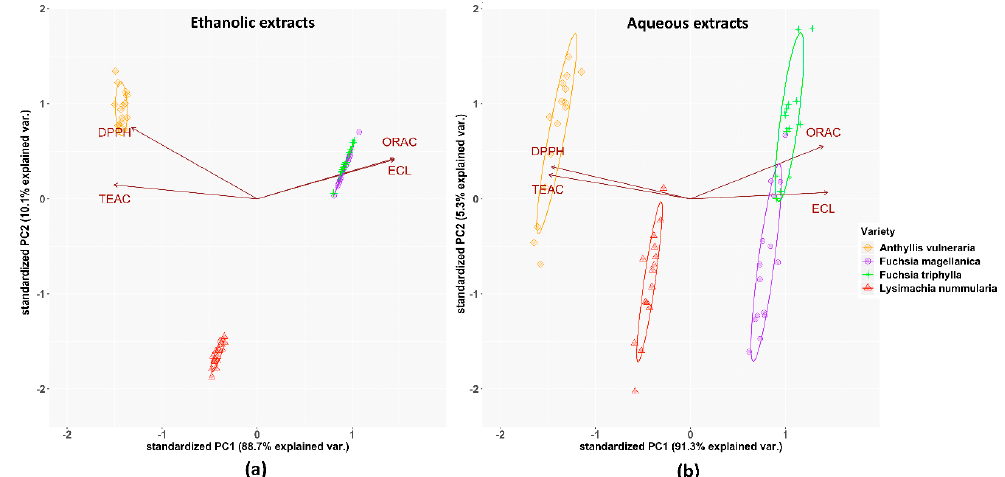
Figure 2. PCA analysis of the investigated plant species’ total antioxidant capacity by four independent methods: ( a ) in the ethanolic extracts, ( b ) in the aqueous solutions, based on the antioxidant activities. % of total variance explained by each axis is provided within the figure. The symbols indicate 15 individual data for each plant extract.